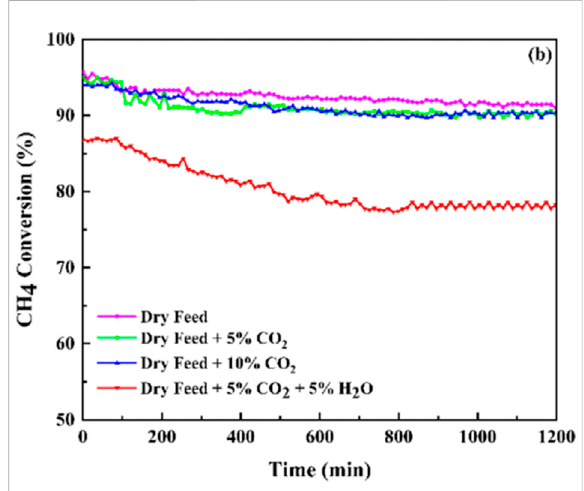
FIGURE 7 Catalytic stability for methane catalytic combustion of the